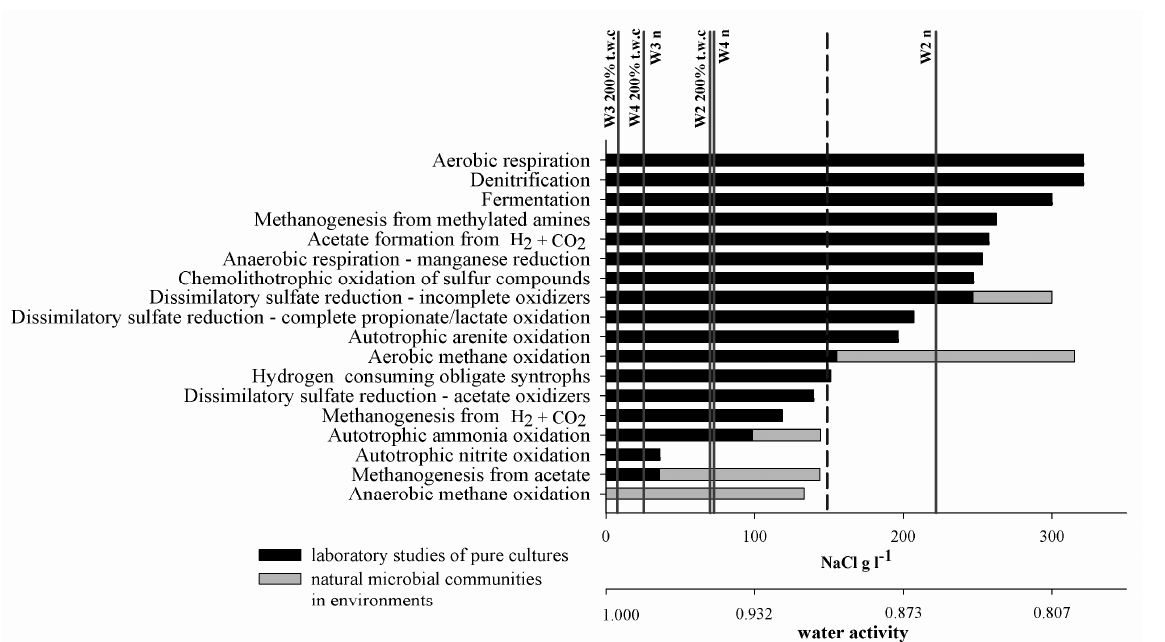
Figure 8. Approximate upper salt concentration limits for the occurrence of selected microbial processes. Dashed line represents 2.5 M NaCl cut-off for extreme halophiles (adapted from Oren [51,52]). Vertical lines represent NaCl concentration in natural moisture samples (W2 n –W4 n ) and in 200% t.w.c. samples (W2 200%t.w.c –W4 200%t.w.c ) (current study).